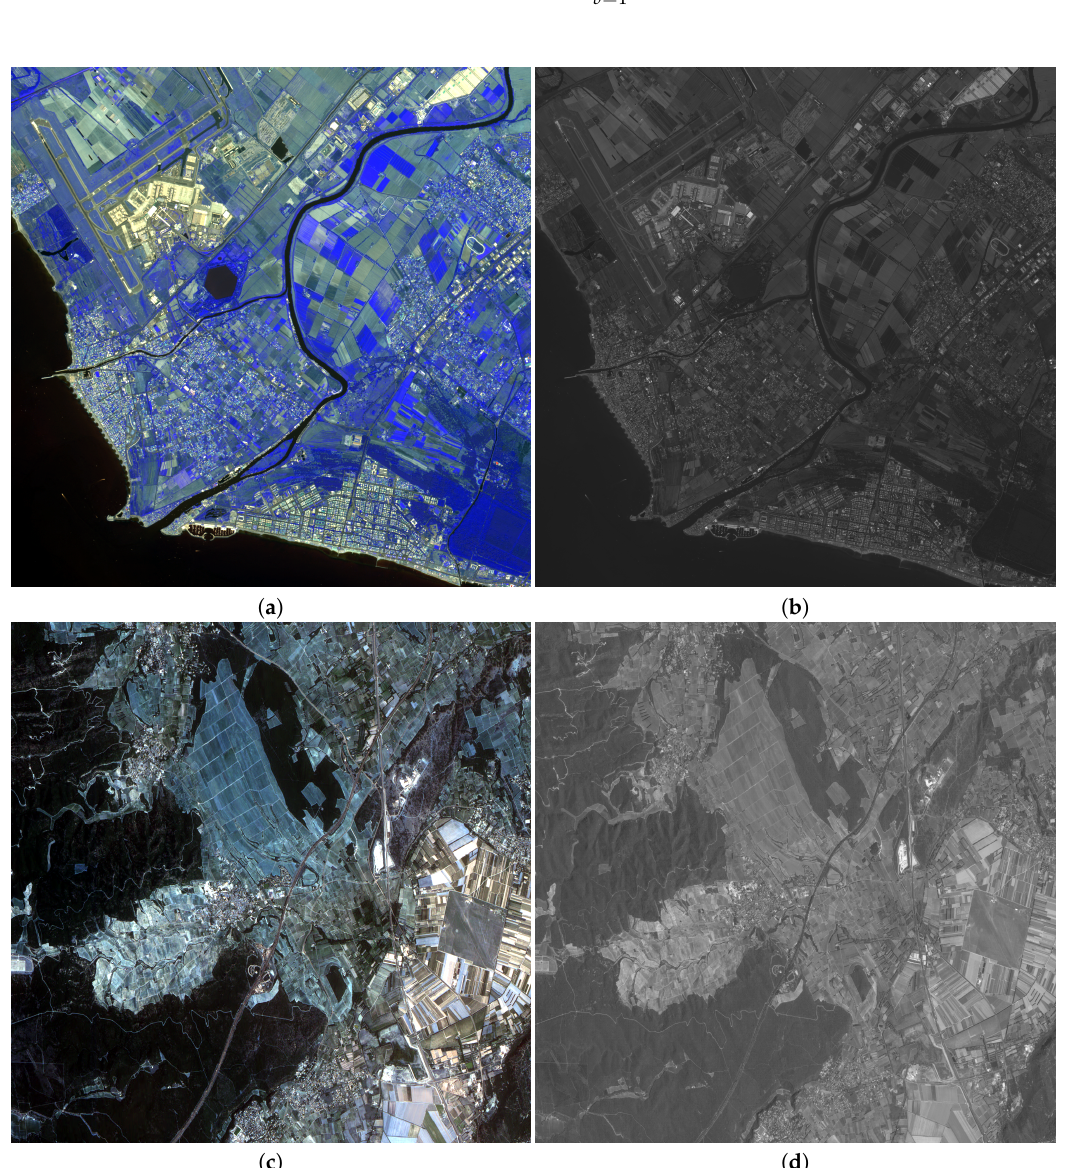
Figure 3. Observed SPOT-5 Roma image: ( a ) 1024 × 1024 MS, ( b ) 4096 × 4096 PAN. FORMOSAT-2 Salon-de-Provence image: ( c ) 1024 × 1024 MS, ( d ) 4096 × 4096